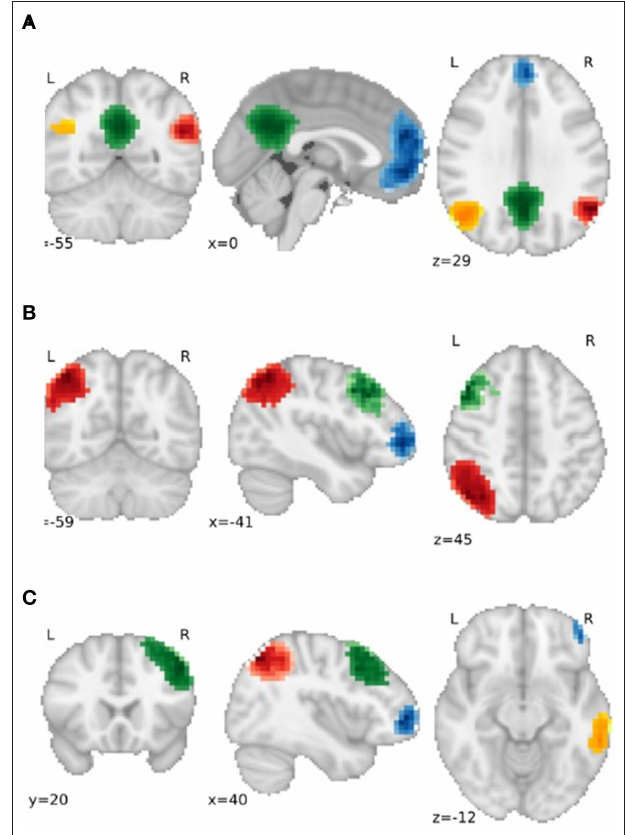
FIGURE 1 | Gray matter regions used as nodes for the (A) default mode network (DMN), (B) Left Frontoparietal Network (FPN) and (C) Right FPN. For (A) , Blue = Frontal DMN, Green = Medial DMN, Orange = Left DMN, Red = Right DMN. For (B) and (C) , Blue = Dorsolateral Prefrontal node, Red = Parietal node, Green = Frontal Pole node, Orange = Posterior Temporal